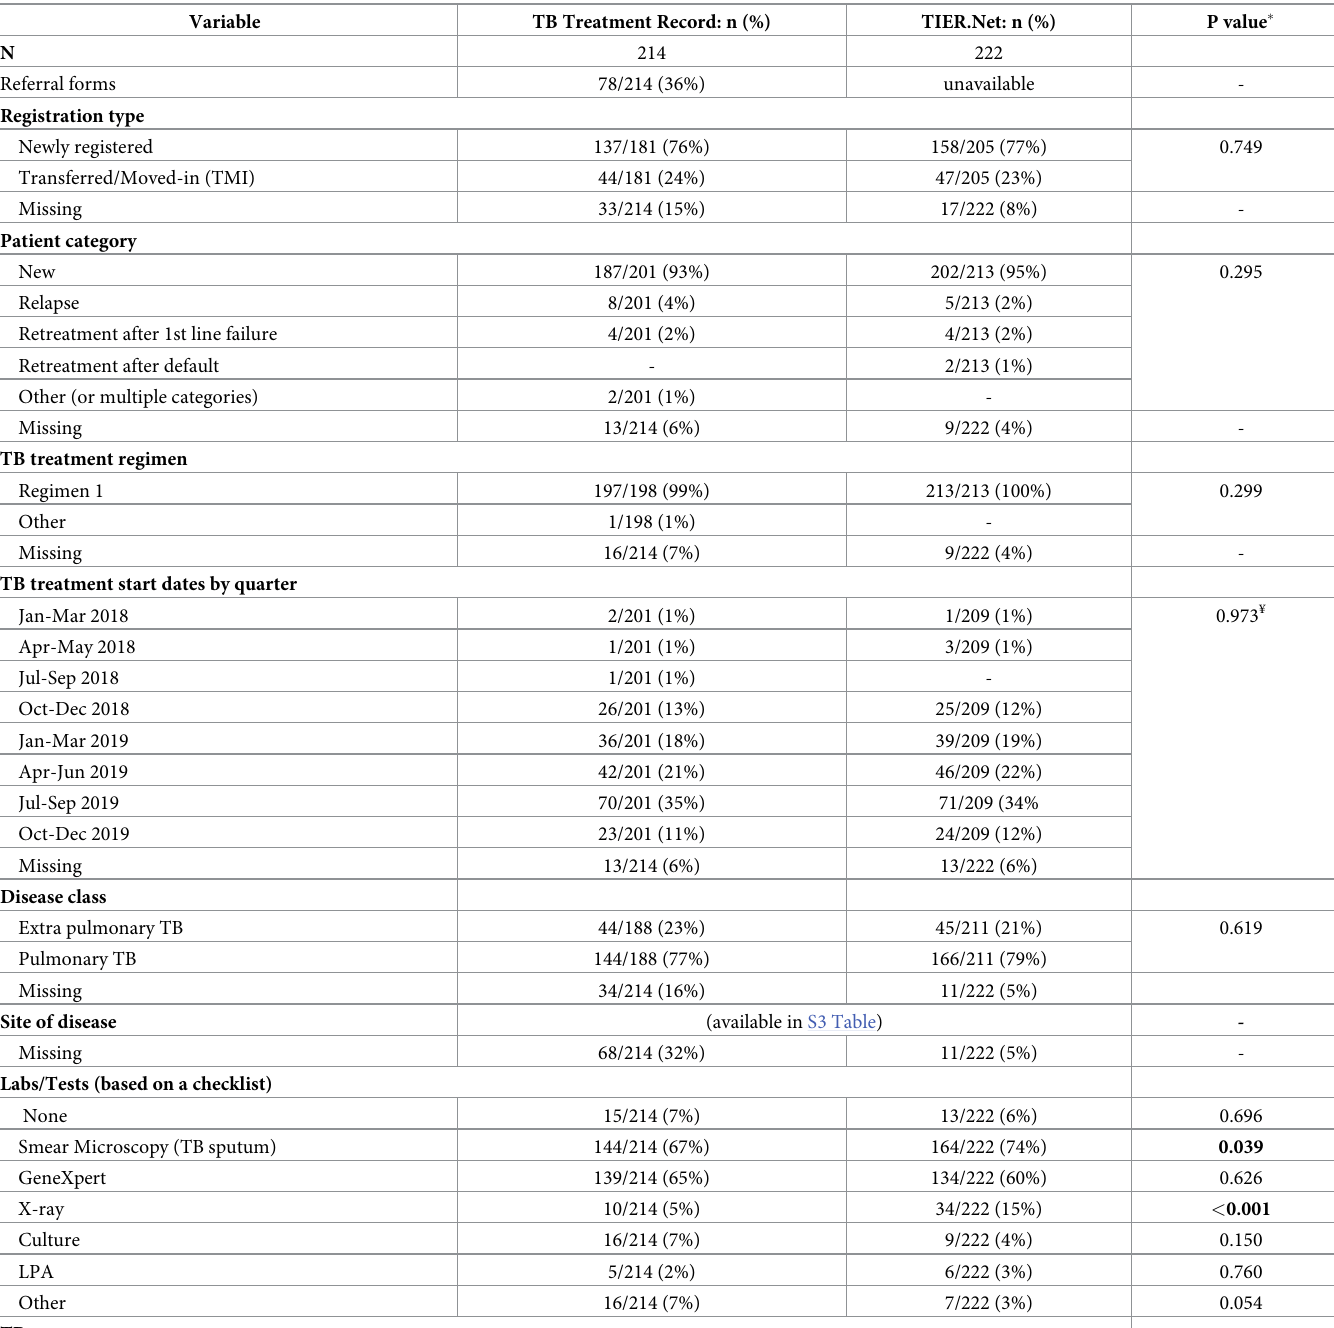
Table 4. Completeness of data between clinic records and TIER.Net for key TB-related variables (n = 222).